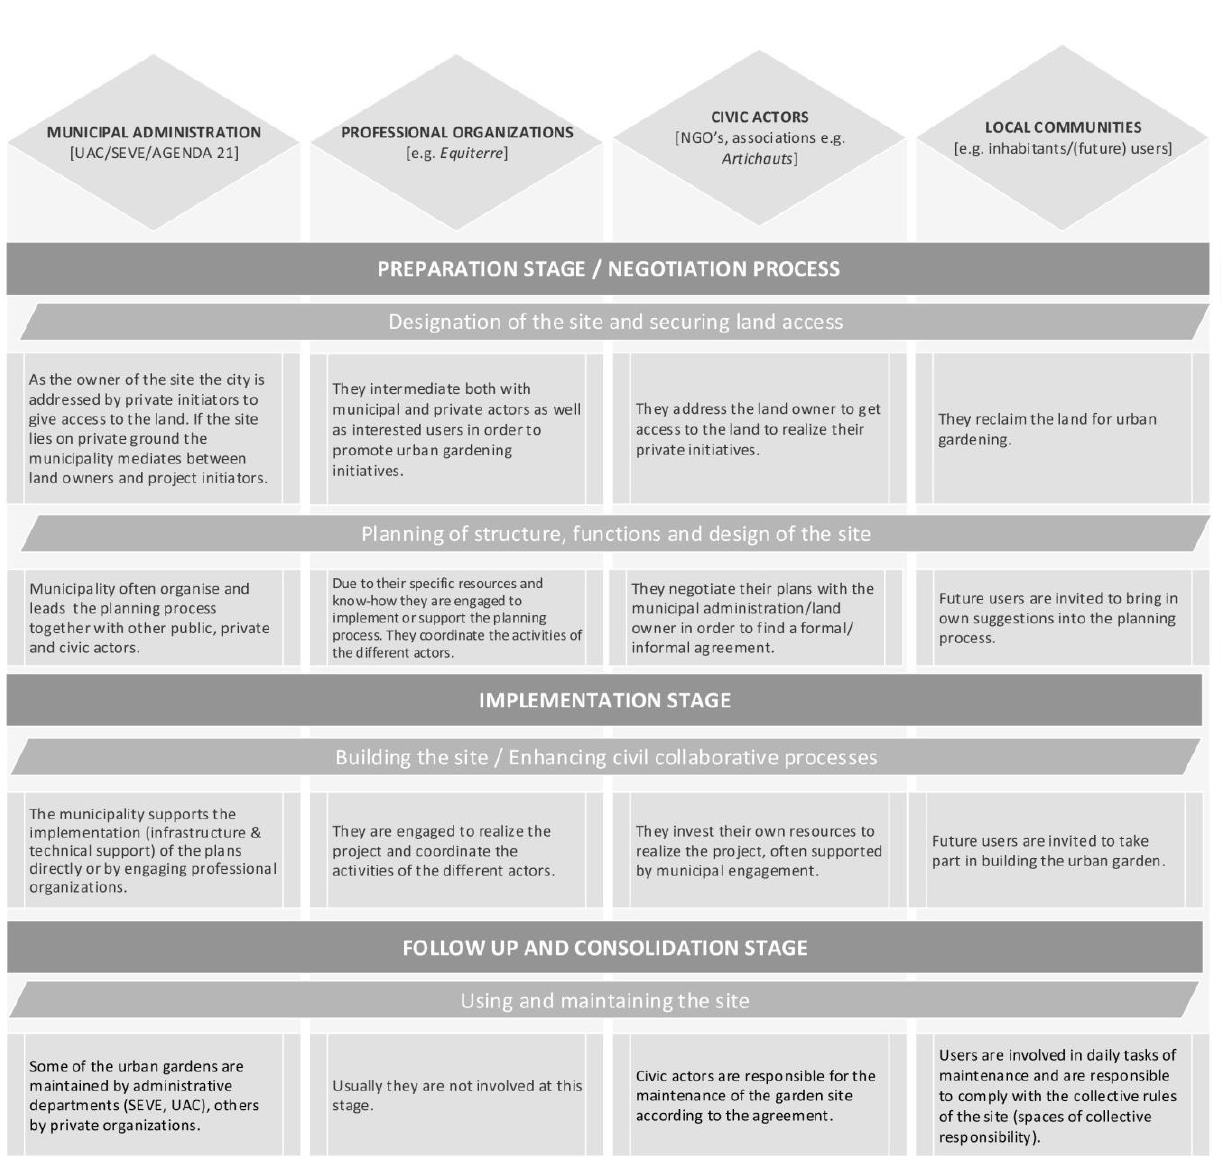
Figure 2. The different collaborative processes in urban gardening and negotiation of space in Geneva: Building consen- sus among actors. Source: